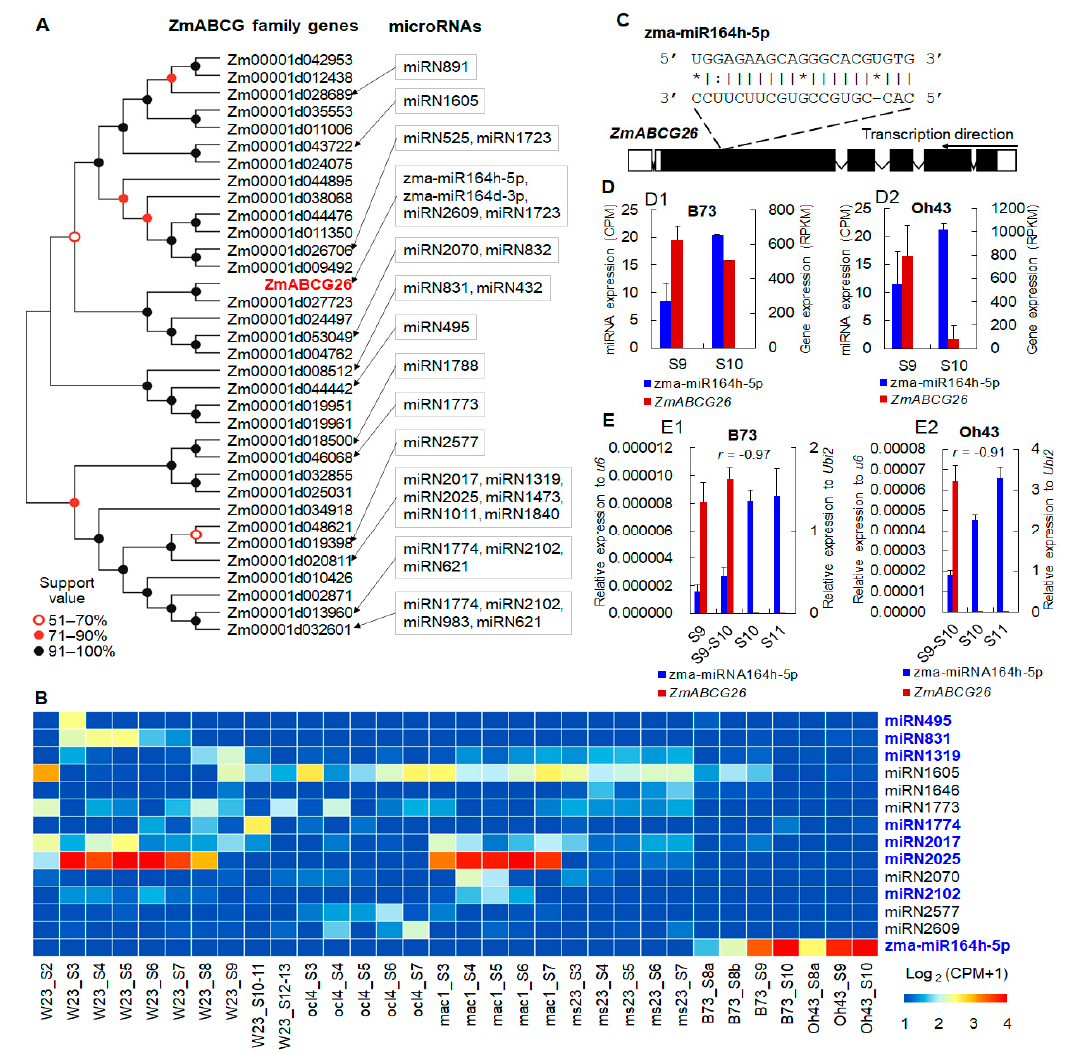
Figure 1. Posttranscriptional regulation of ZmABCG26 by zma-miR164h-5p during maize anther development: ( A ) the phylogenetic tree of maize ABCG family genes and their predicted miRNA regulators during anther development; ( B ) transcriptome analyses of expression patterns of predicted miRNA regulators of maize WBC/ABCG family genes in anthers of WT inbred lines (W23, B73, and Oh43) and GMS mutant lines ( ocl4 , mac1 , ms23 ). The names of predicted miRNA regulators having negatively correlated expression levels with their ABCG target genes (Pearson correlation test) were marked in blue; ( C ) the sequence alignment of zma-miR64h-5p and its target site on the ZmABCG26 transcript. *, base mismatch; ( D , E ) the negatively correlated expression patterns between ZmABCG26 and zma-miR164h-5p in B73 ( D1 , E1 ) and Oh43 ( D2 , E2 ) inbred lines at anther developmental stages 9 and 10 revealed by transcriptome analyses ( D ) and at stages 9 to 11 confirmed by qRT-PCR analyses ( E ). r , Pearson correlation coefficient.